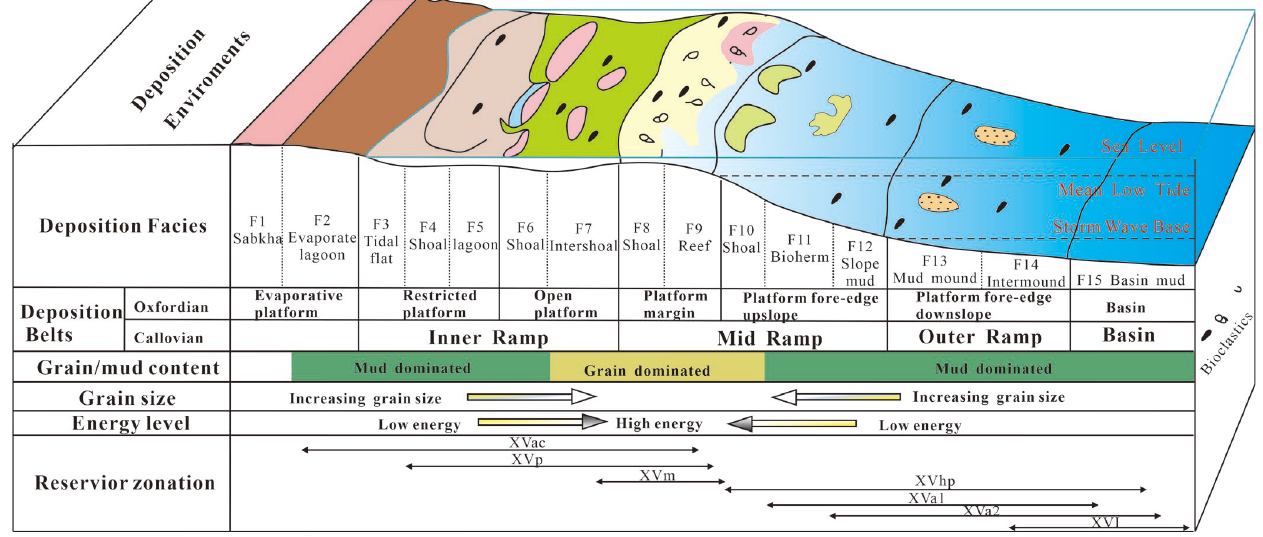
Figure 8. Conceptual depositional model presented for the Callovian-Oxfordian stage in the Amu Darya Basin. Darya